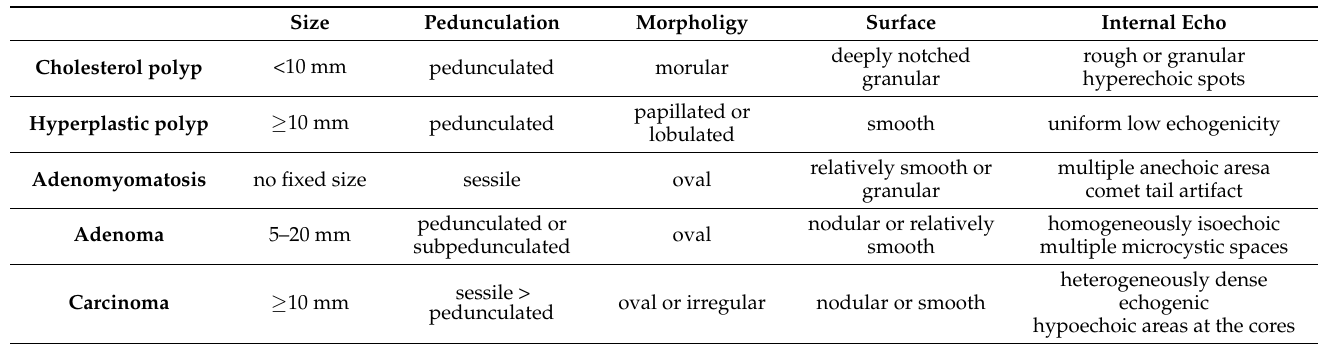
Table 3. EUS features of major GB protuberant